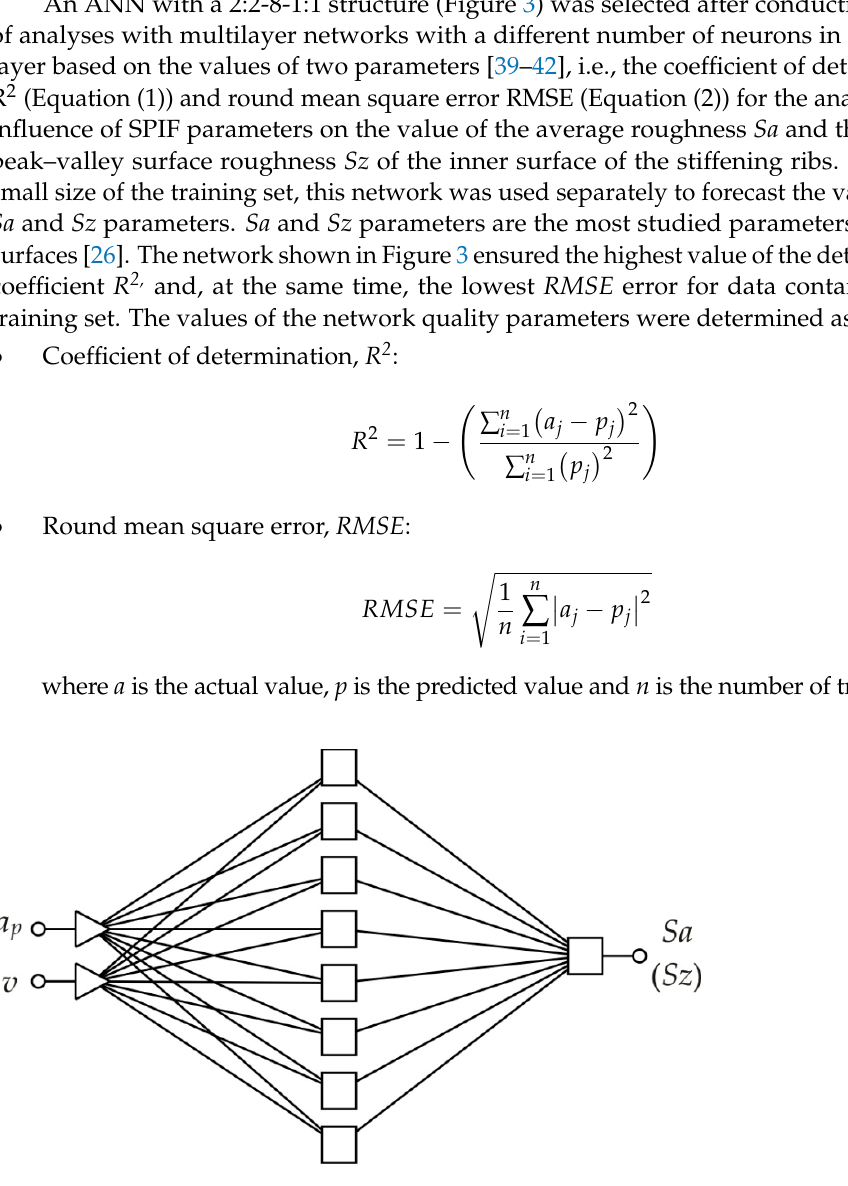
Figure 3. The architecture of the network used to analyse the effect of SPIF parameters on the value of the Sa roughness parameter.